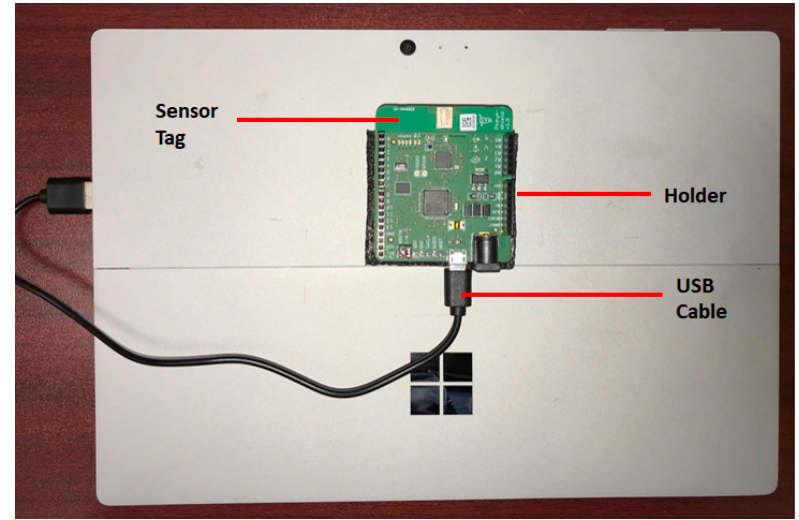
Figure 10. Physical integration of tag and tablet to be used on jobsite.